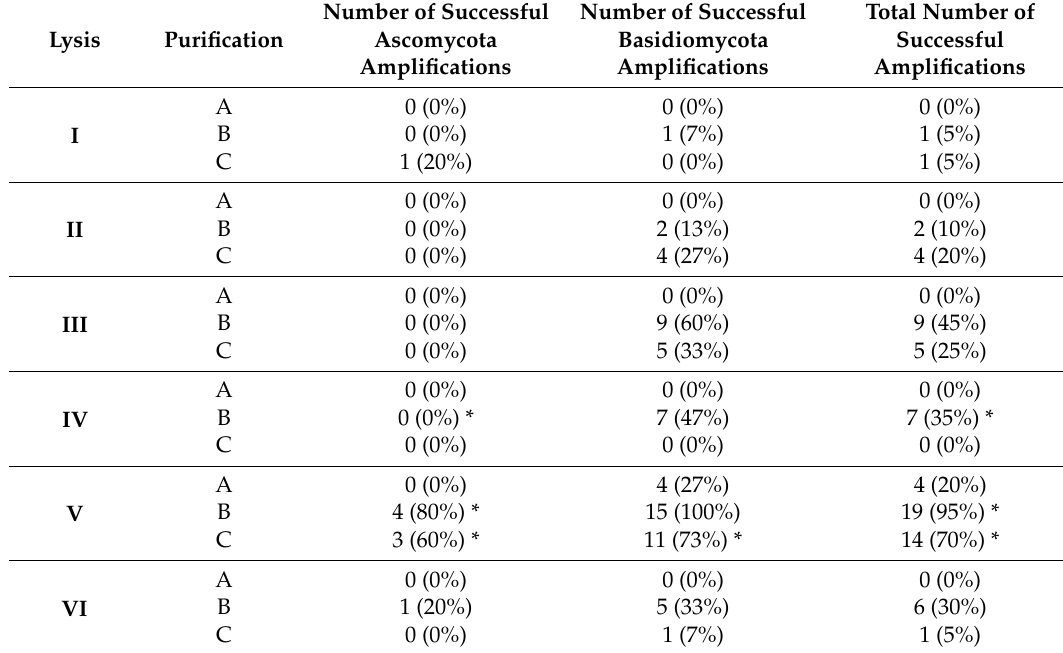
Table 3. The number of successful transcribed spacer regions (ITS) amplifications of isolates prepares with specific lysis and purification protocols, based on the DNA sequencing of the final reaction product. The total number (100%) of samples was 20, which included 5 Ascomycota and 15 Basidiomycota